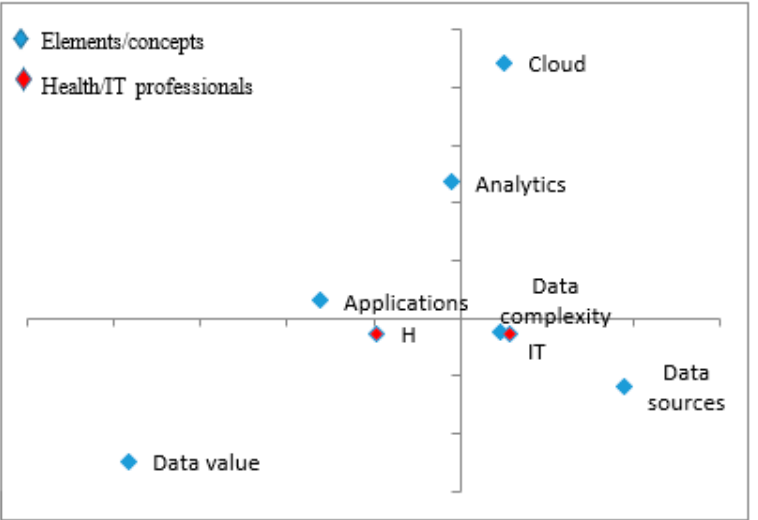
Figure 3. Defining Big Data.